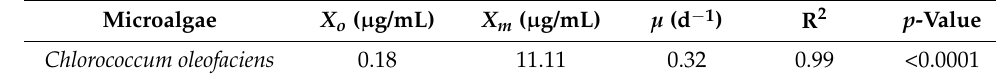
Table 5. Values of kinetic coefficients.